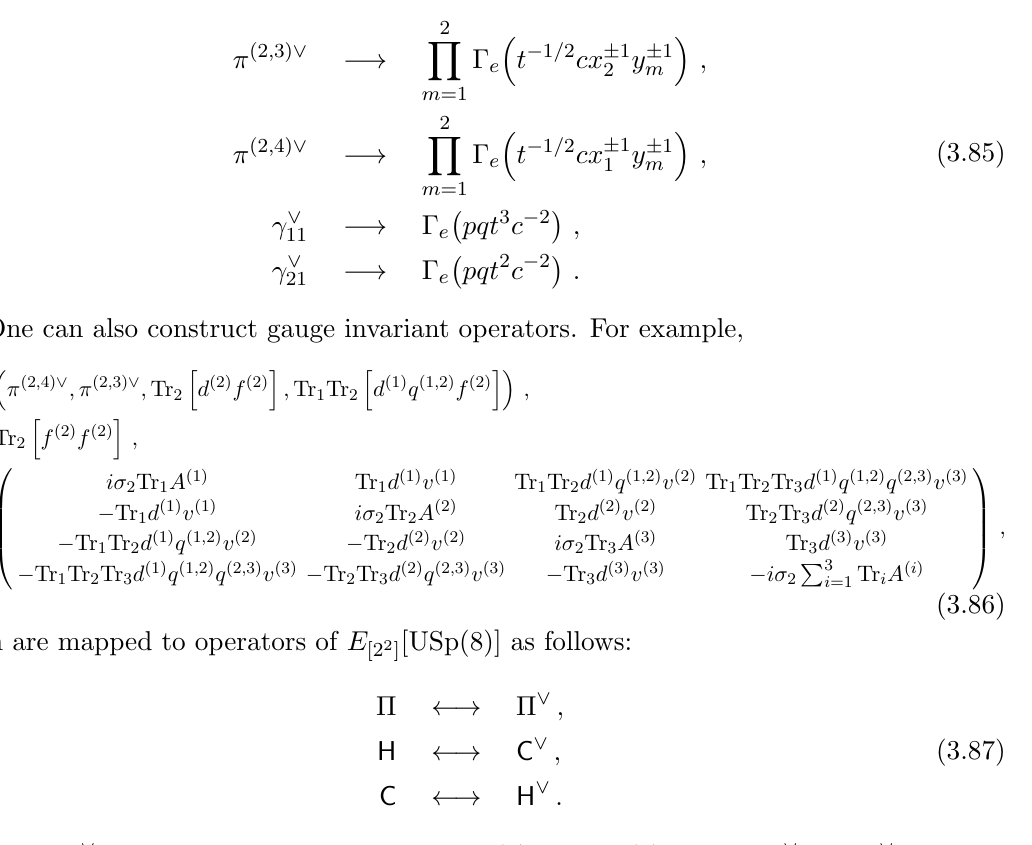
h i h i d (1) d (1) and Tr 2 d (2) d (2) [1 2] [1 2]